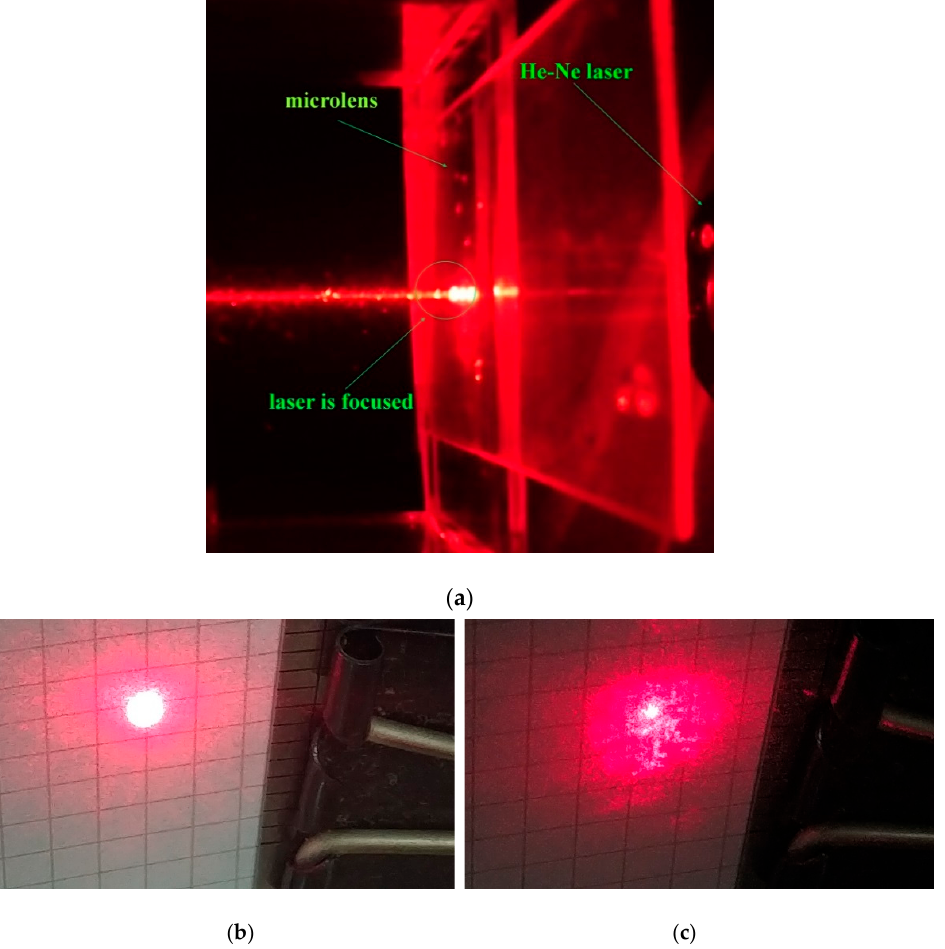
Figure 10. ( a ) The He-Ne laser is focused by using the microlens. ( b ) The light spot of laser beam without passing through lens projects on screen. ( c ) The light spot of laser beam passing through lens projects on screen.